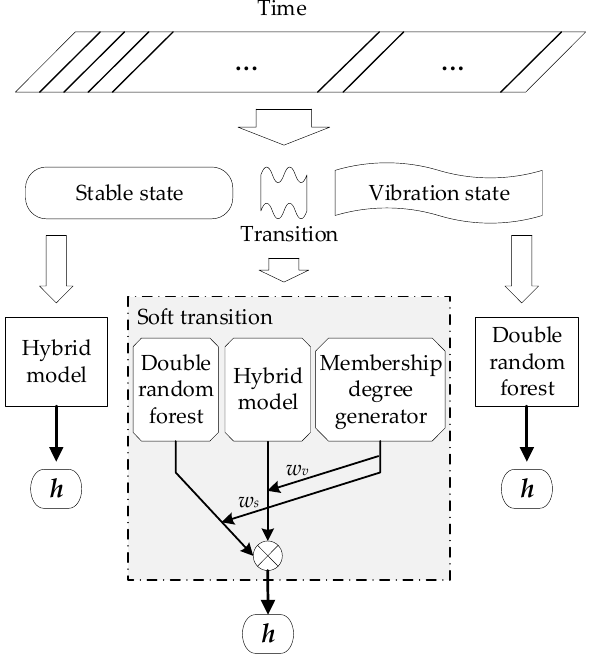
Figure 5. Schematic of the multi-model floating height soft sensor.